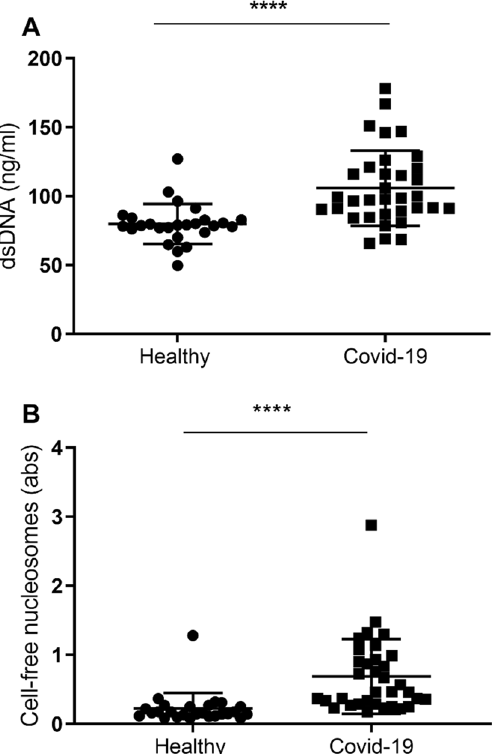
Figure 5. Plasma of COVID-19 patients shows increased levels of dsDNA (A) and cell free nucleosomes— markers of